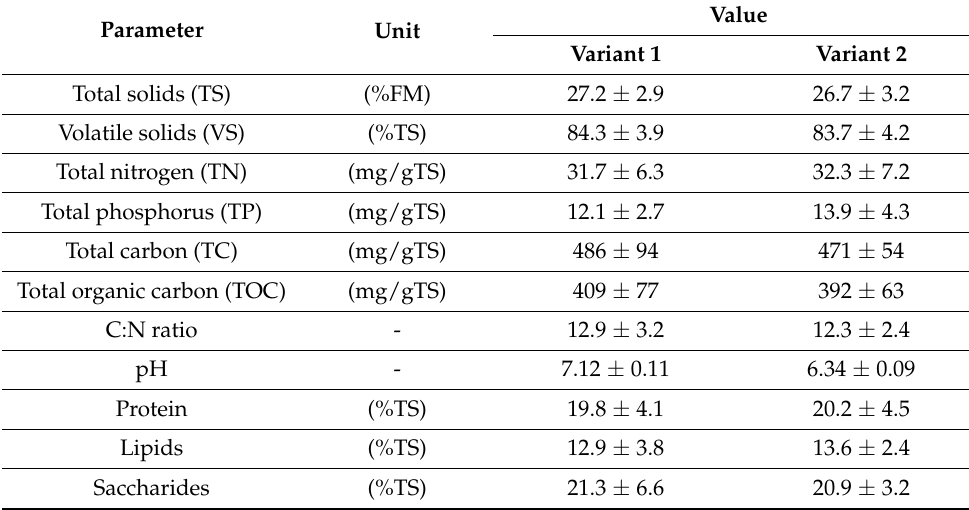
Table 2. Characteristics of the biomass of hydrophytes harvested by hacking the bottoms of water reservoirs in stage 2 of the study.